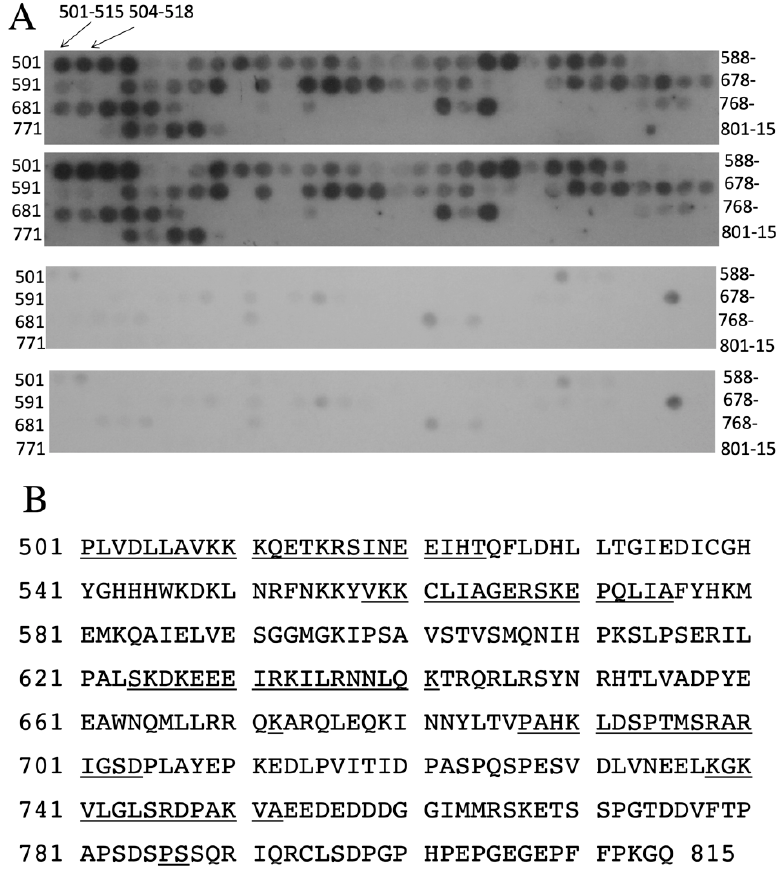
Figure 5. ( A – D ) Mass spectrometry analysis of tryptic fragments of bands 1 ( A , B ) and 2 ( C , D ) of wild-type ( A , C ) and phosphomimetic mutant ( B , D ) His-182 proteins. The bands were excised and treated with trypsin and fragments were analyzed by mass spectrometry as described in the “Ma- terials and Methods” section. The sum of the total extracted ion intensity was used to plot the ob- served relative amount of each fragment. WT, wild-type His-182 protein, Mu, phosphomimetic mu- tant His-182 protein. The theoretical peptides are shown on the X-axis. % of total fragments found is plotted for each peptide.